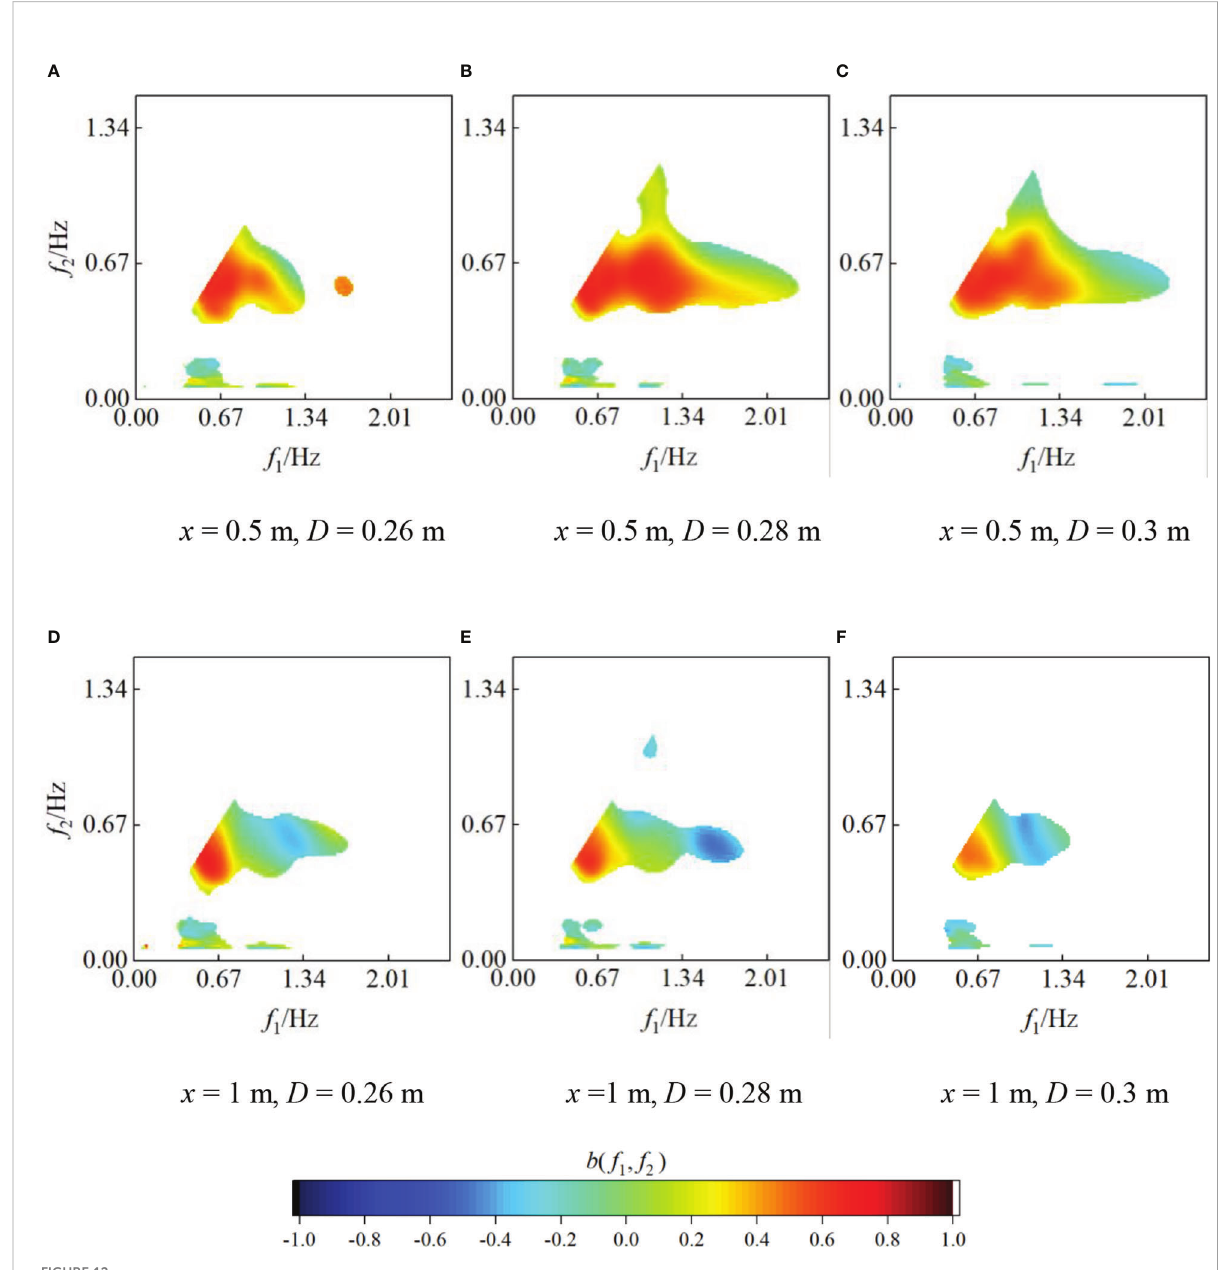
FIGURE 12 Changes in the wavelet-based bispectrum under different water depths (M1, H i = 0.043 m, T = 1.5 s) (A) x = 0.5 m, D = 0.26 m (B) x = 0.5 m, D = 0.28 m (C) x = 0.5 m, D = 0.3 m (D) x = 1 m, D = 0.26 m (E) x =1 m, D = 0.28 m (F) x = 1 m, D = 0.3